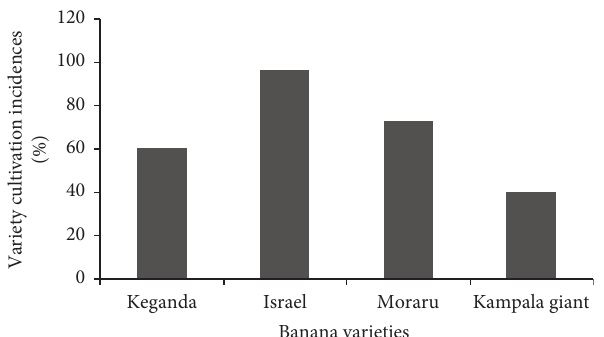
Figure 9: Local banana varieties in Embu County.